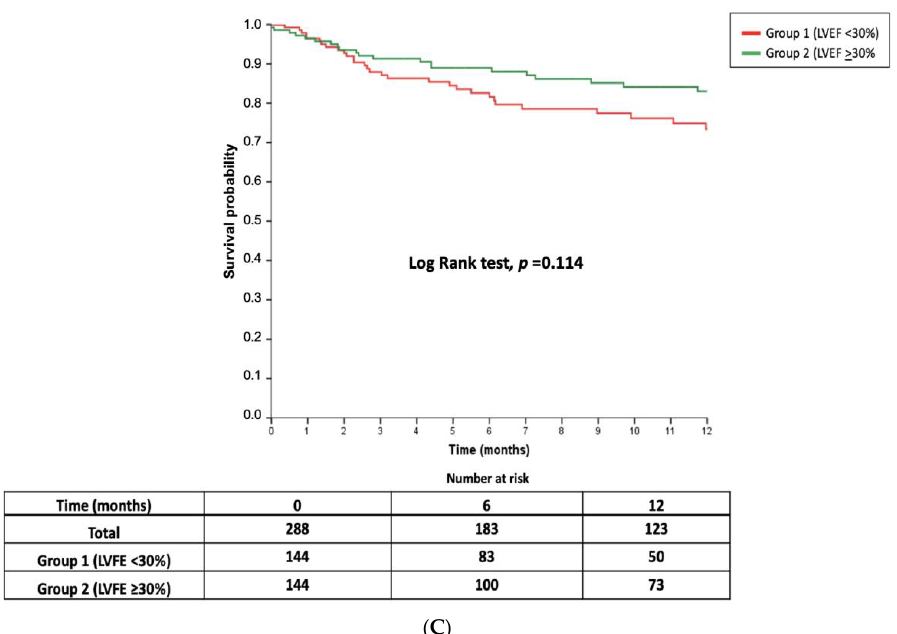
Figure 2. Twelve-month survival curves for the composite event ( A ) Composite event (death/unplanned hospitalization), all-cause mortality. ( B ) All-cause mortality and readmission for heart failure ( C ) Readmission for heart failure according to LVEF groups.